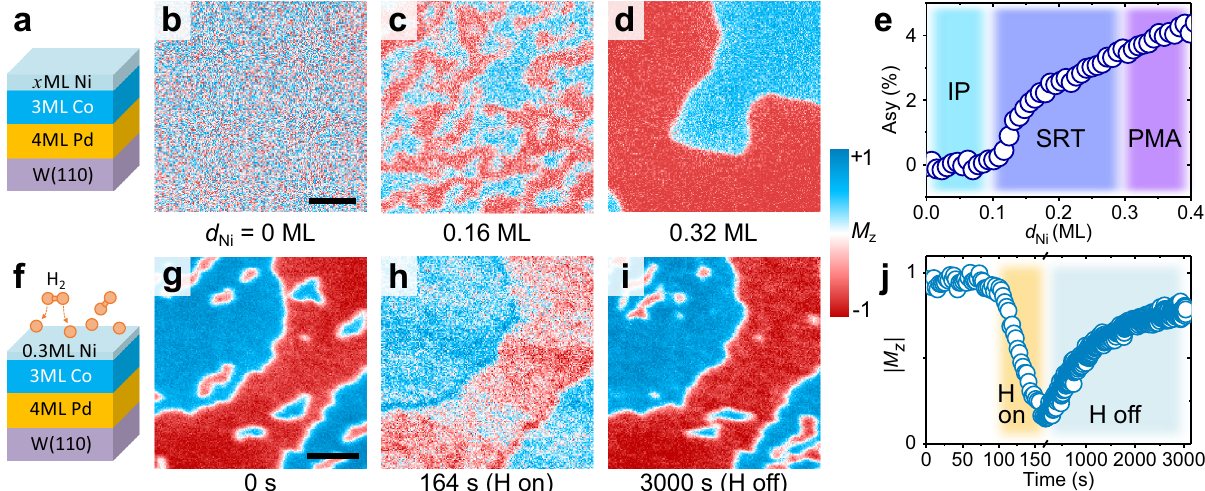
Fig. 1 Hydrogen-induced magnetic anisotropy in Ni/Co/Pd/W system. a Sketch of the sample structure. b – d Ni thickness d Ni dependent SPLEEM images with out-of-plane sensitivity in Ni/3 ML Co/4 ML Pd/W(110) system, showing evolution of perpendicularly magnetized domains. Scale bar 1 μ m. e d Ni dependent electron re fl ectivity spin-asymmetry of perpendicularly magnetized domains. IP, SRT, PMA stand for in-plane, spin reorientation transition and perpendicular magnetic anisotropy, respectively. f – i Hydrogen-induced evolution of domains with out-of-plane sensitivity. Scale bar 1 μ m, indicating in- plane anisotropy induced by (cid:1) 0.7 Langmuir hydrogen on 0.3 ML Ni/3 ML Co/4 ML Pd/W(110) (panels g and h ), and recovered perpendicularly magnetized domains upon hydrogen desorption (panel i ). j Time-dependent switching of out-of-plane magnetization ( M z ON/OFF cycle.